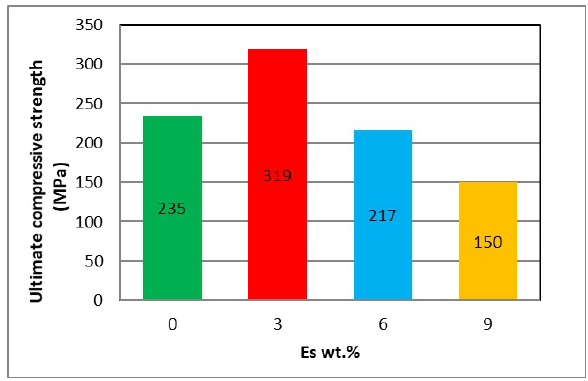
Figure 8: Bar graph of compressive strength of Al-1.5Mg-1.5Sn-(X)Es composite.